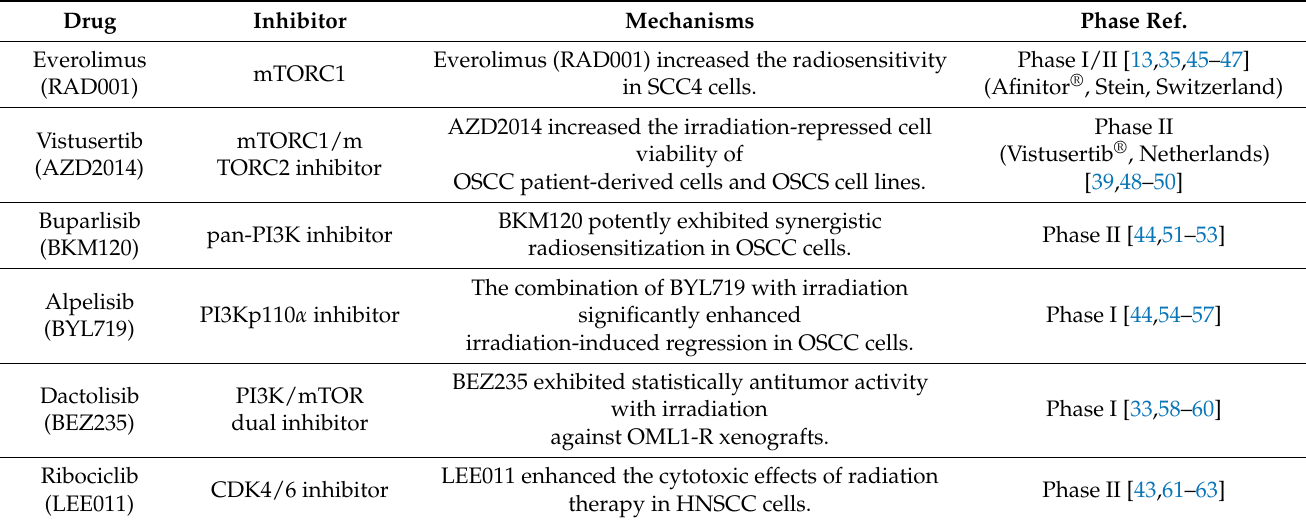
Table 1. Inhibitors of PI3K/AKT/mTOR signaling pathway as radiosensitizers for the treatment of